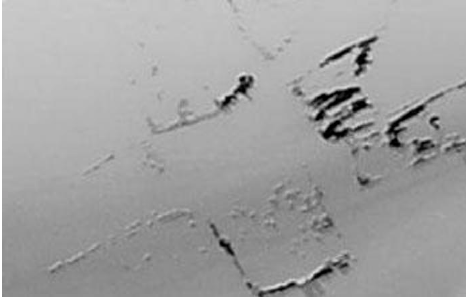
Figure 7. The image after bicubic interpolation.